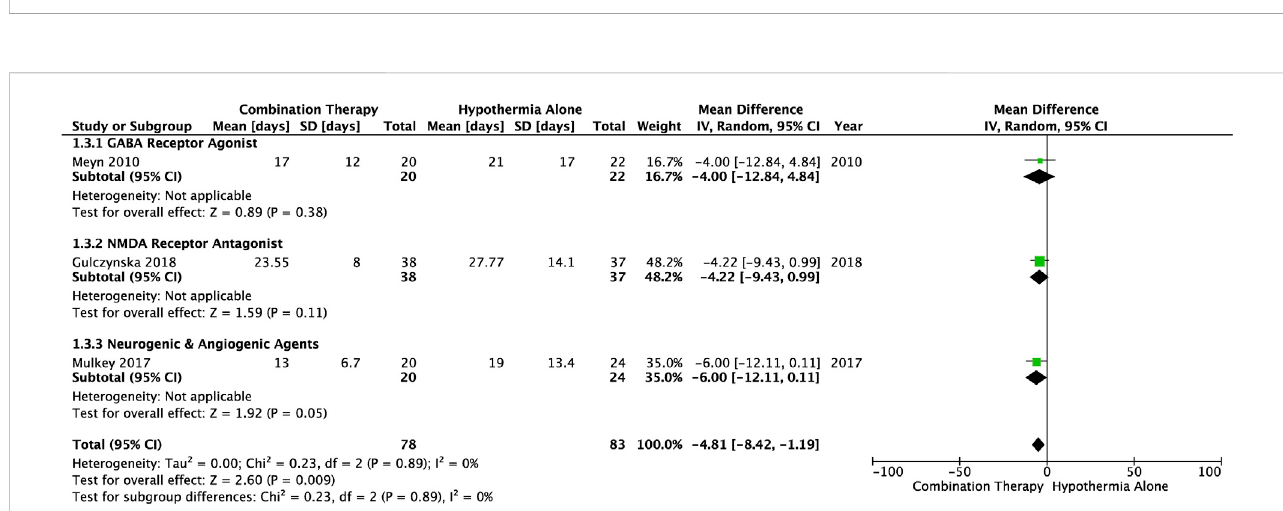
Forest plotofNDIinHIEinfants treatedwithcombinationtherapycomparedto THalone.AnOR < 1suggestscombinationtherapyismore favourableto reduce the risk of an NDI diagnosis. Standardized tests used to diagnose NDI and timepoint of diagnosis for each study are outlined in Table 1. OR .82, 95% CI [.55 to 1.23], p = .34. Combination therapy with an antioxidant signi fi cantly reduced risk of NDI: OR .15, 95% CI [.03 to .87], p = .03.